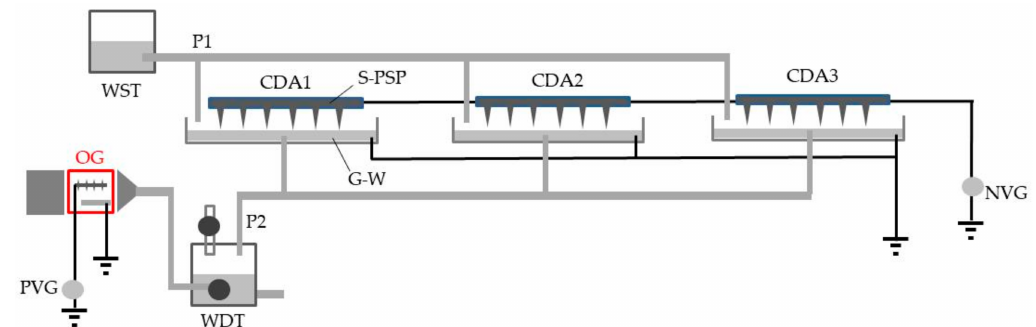
Figure 3. Schematic representation of the total system containing three corona discharge-generating apparatuses linked to each other (CDA1–3) and an ozone generator (OG). WST, water-supply tank; CDA1–3; three CDAs whose S-PSPs and G-waters (refer to the legend of Figure 1) are linked to a negative voltage generator and grounded line, respectively; NVG, negative voltage generator; PVG, positive voltage generator; WDT, water-drain tank; S-PSP, spiked perforated stainless plate; G-W, grounded water; P1, pipe from the water-supply tank to the water vessel of each CDA; P2, pipe from the water vessels of the CDAs to a water-drain